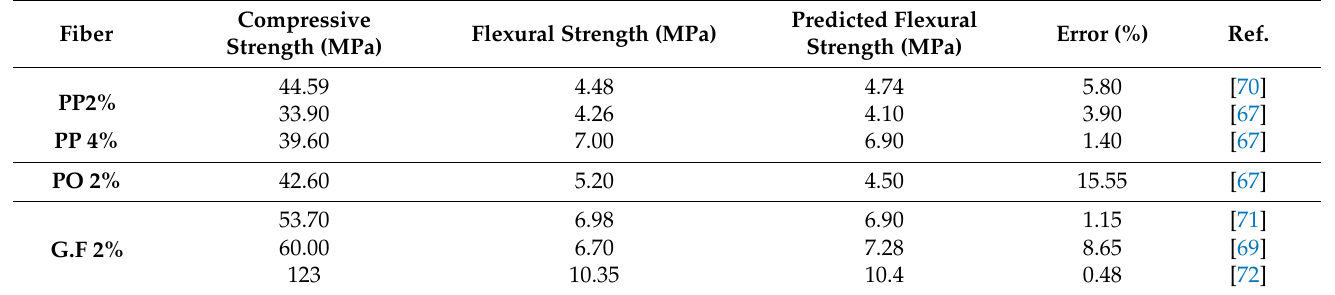
Table 10. Verification of proposed β values using an external data